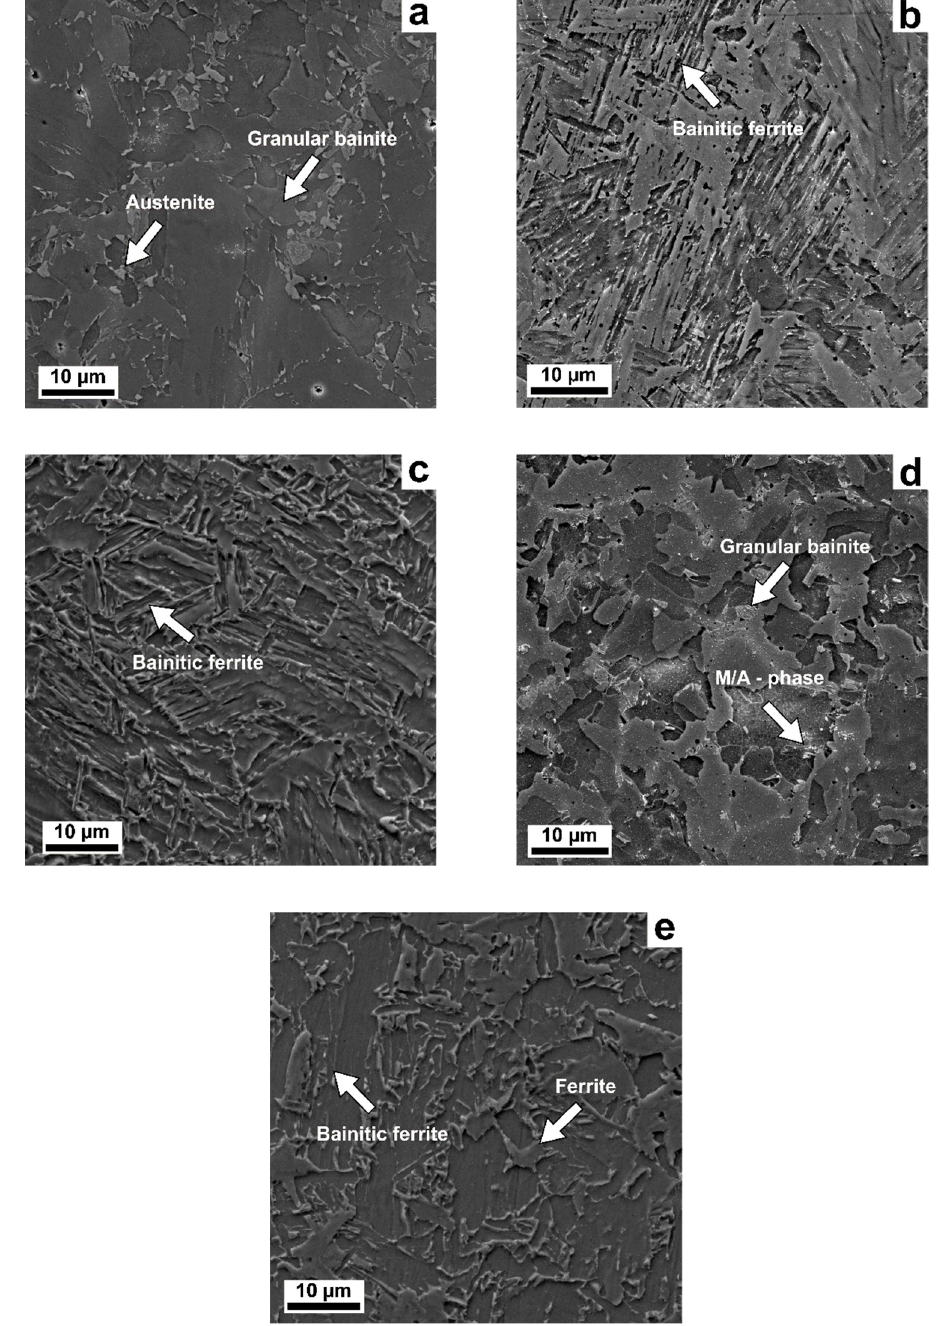
Figure 4. Microstructure of 09CrNi2MoCu steel in various states: ( a ) rolled products; ( b ) T1 (steel in initial state after DLD); ( c ) T2 (DLD + HT); ( d ) T3 (DLD + HT); ( e ) T4 (DLD + HT). The microstructure after rolling is granular bainite (Figure 4a) with retained austenite content. After heat treatment according to T3 mode (Figure 4d), the microstructure con- sists of granular bainite with martensite and retained austenite (M/A) phase. In the sample